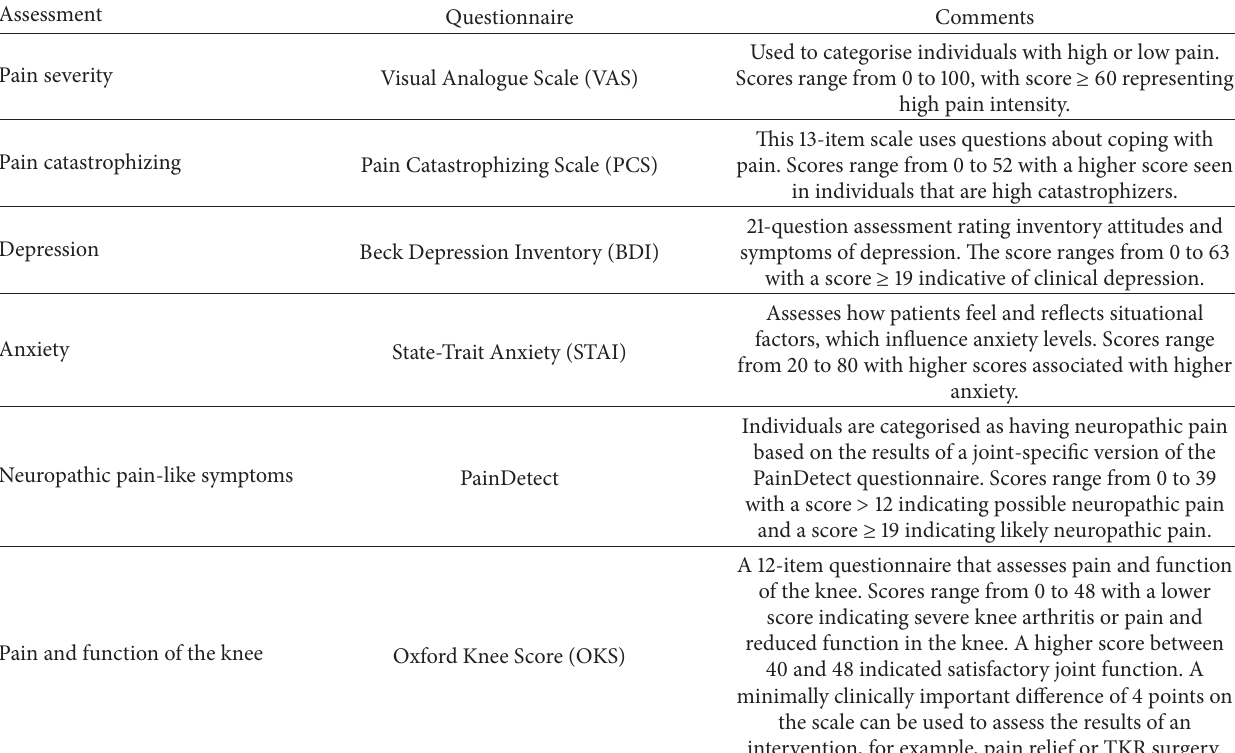
Table 1: Pre- and postoperative questionnaires.